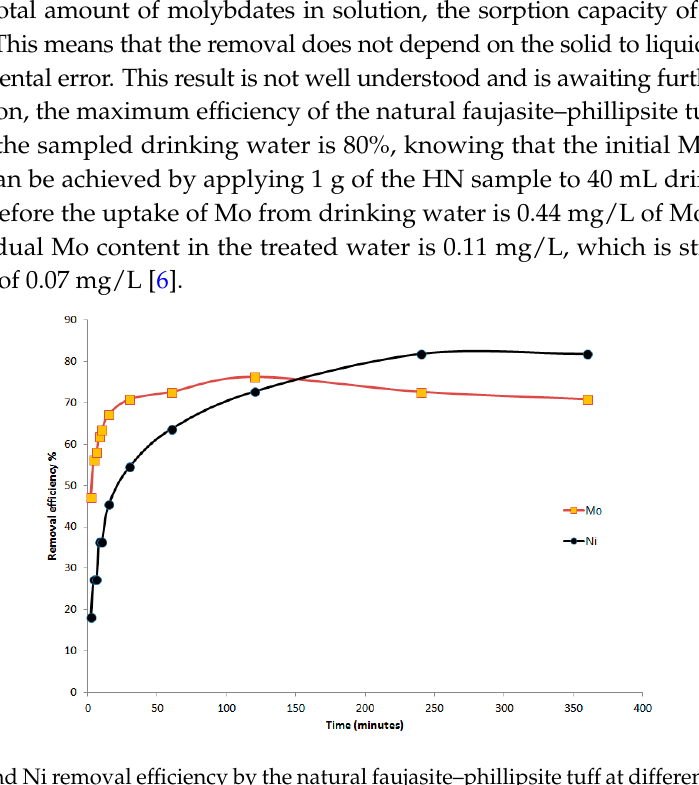
Figure 5. Mo and Ni removal efficiency by the natural faujasite–phillipsite tuff at different contact times.